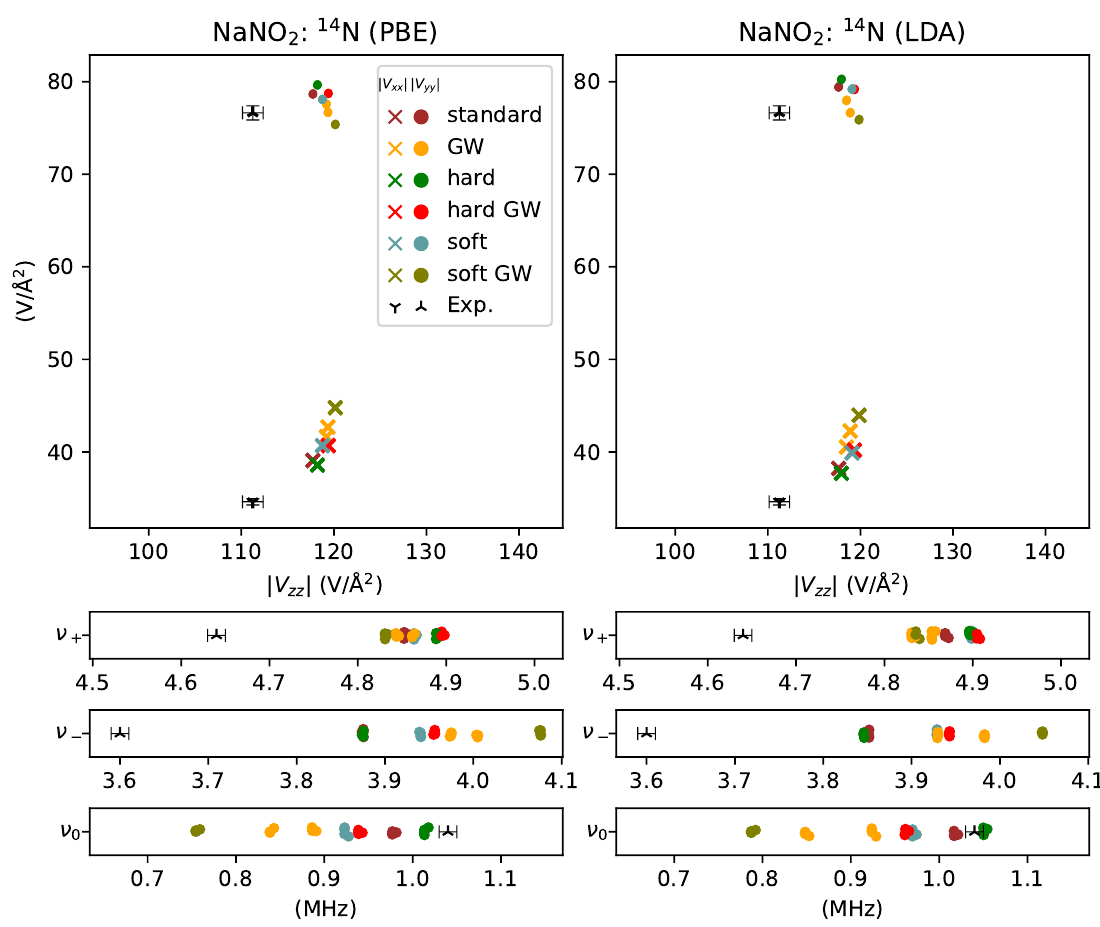
Figure 1. EFG plots for the 14 N site in NaNO 2 , utilizing both PBE (left) and LDA (right) functionals are shown at the top; the corresponding NQR frequencies are shown underneath. Colored markers show a computed value for each PAW potential. Experimental data [39,46], shown in black, is close to calculated results, δ ≤ 10%. The V xx and V yy components were computed to be positive and V zz